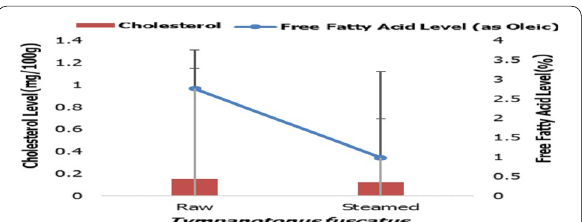
Fig. 1 Cholesterol and free fatty acid contents of raw and steamed edible part of T. fuscatus var radula